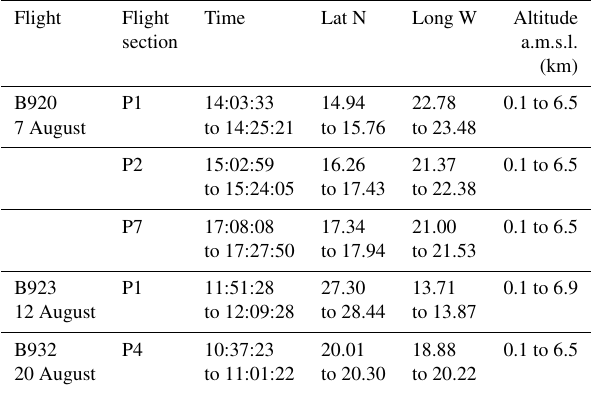
Table 2. Summary of the aircraft profiles from each of the flights used here. Flight sections are labelled with the letter P (profiles); see the text. All times are in